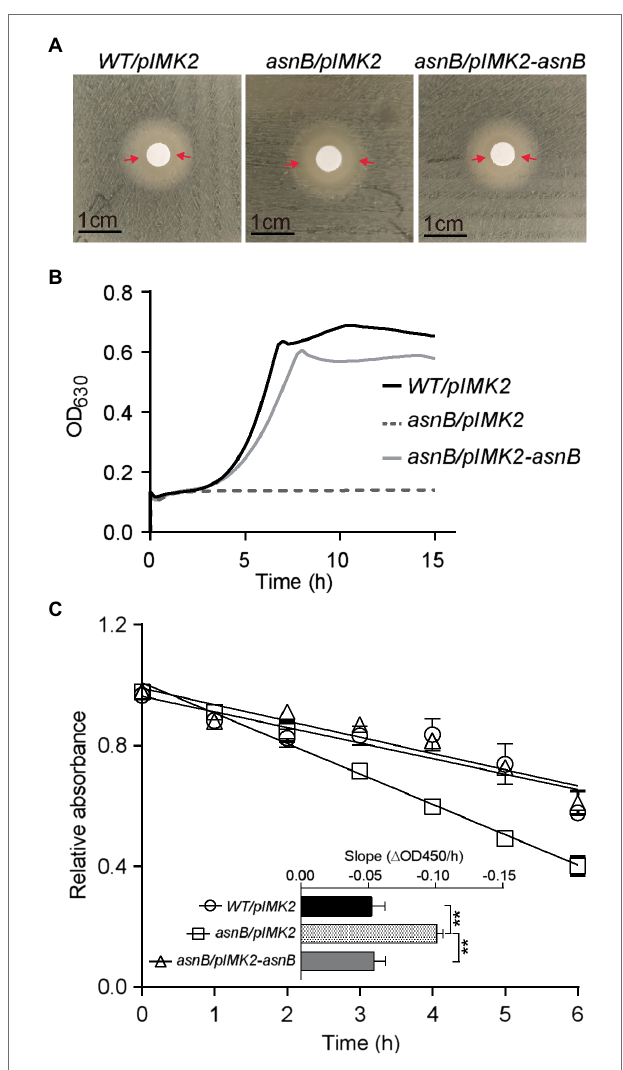
FIGURE 4 | Lysozyme sensitivity of the L. monocytogenes asnB mutant. (A) Disk diffusion assay of WT/pIMK2 , asnB/pIMK2 , and asnB/pIMK2-asnB strains. The zone of clearance is indicated with red arrows. Images are representative of at least three independent experiments. (B) Growth of the same strains in BHI broth with 1 mg/ml lysozyme at 30 ° C. Graphs are means of three independent experiments. (C) Lysis of cell suspensions of the same strains in potassium phosphate buffer in the presence of 0.1 μ g/ml lysozyme. The relative absorbance on the y -axis represents the ratio of absorbance (OD 450 ) in the presence of lysozyme vs. water as a control. The inset shows the slopes of linear regression curves from the main graph. Data represent mean ± SD; n = 5; **, p < 0.0021 by two-tailed student’s t